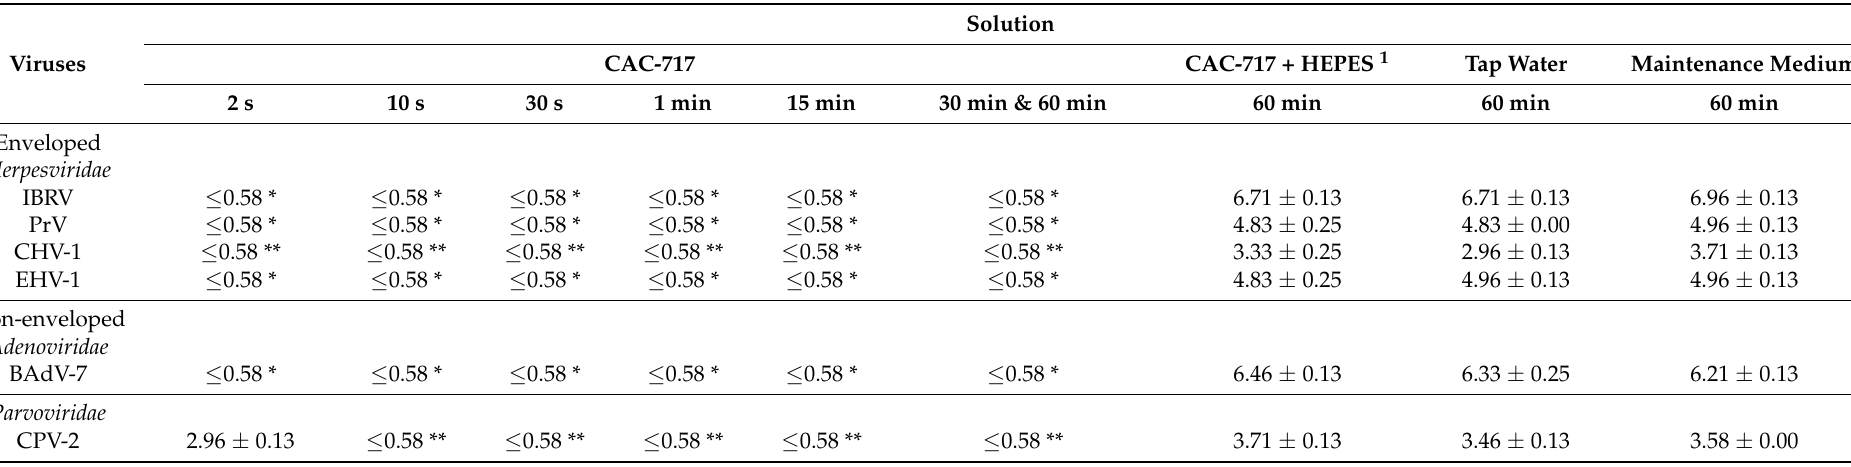
Table 2. Virucidal effects of CAC-717 on various DNA viruses. Viral titer is shown as log 10 TCID 50 /25 µ L (mean ± SE). Values are representative values from two separate experiments.